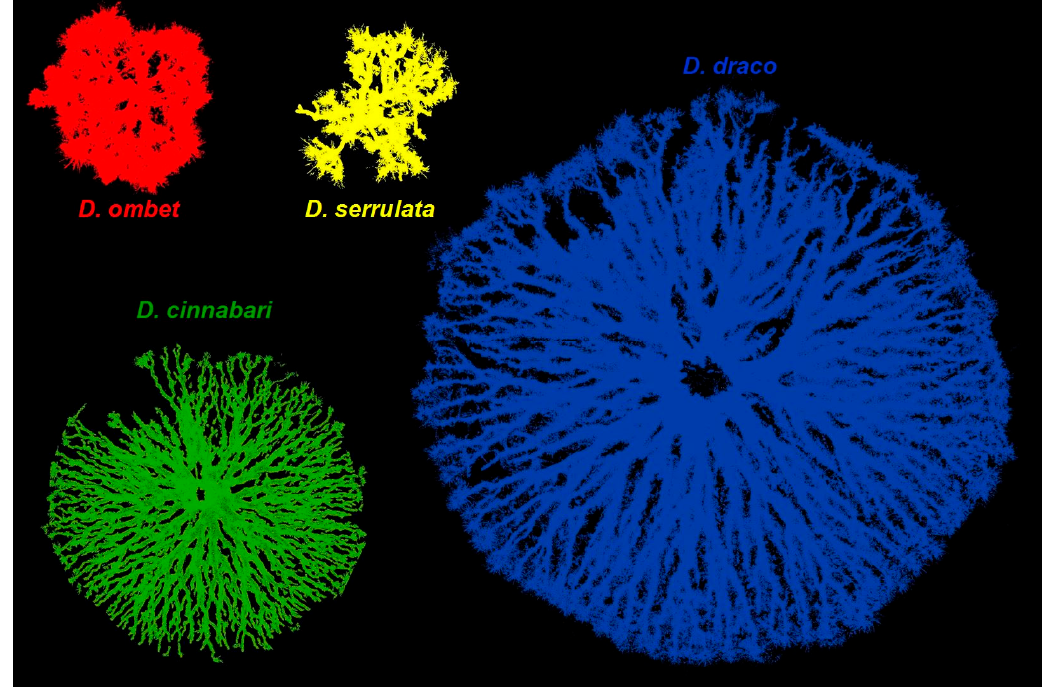
Figure 11. Horizontal cuts of the widest canopy parts of the largest examples of created 3D tree point clouds of all studied species.